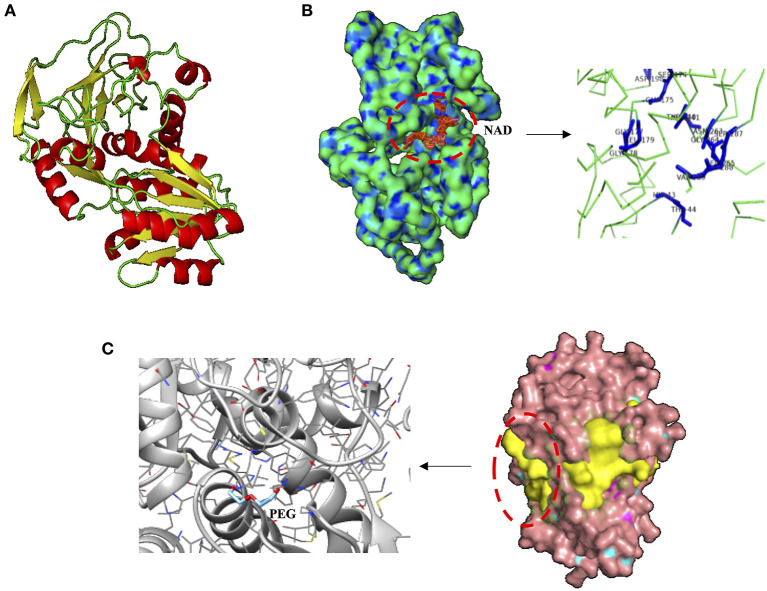
Structural analysis of alcohol dehydrogenase (ADH) from Cobetia sp. (HA399_02440). (A) Protein prediction of ADH showing, (B) the nicotinamide-adenine-dinucleotide (NAD) dependence, displaying the ligand binding residues HIS 43, THR 44, SER 174, GLY 175, GLY 177, GLY 178, LEU 179, ASP 198, THR 240, ASP 241, ASN 263, GLY 264, LYS 265, SER 287, ILE 288, and VAL 289. (C) The three of the most probable pockets of the ADH (potential sites of ligand binding, in yellow), and the docking site (prediction of the orientation and position of protein-ligand complex) between the polyethylene glycol (PEG) and ADH.